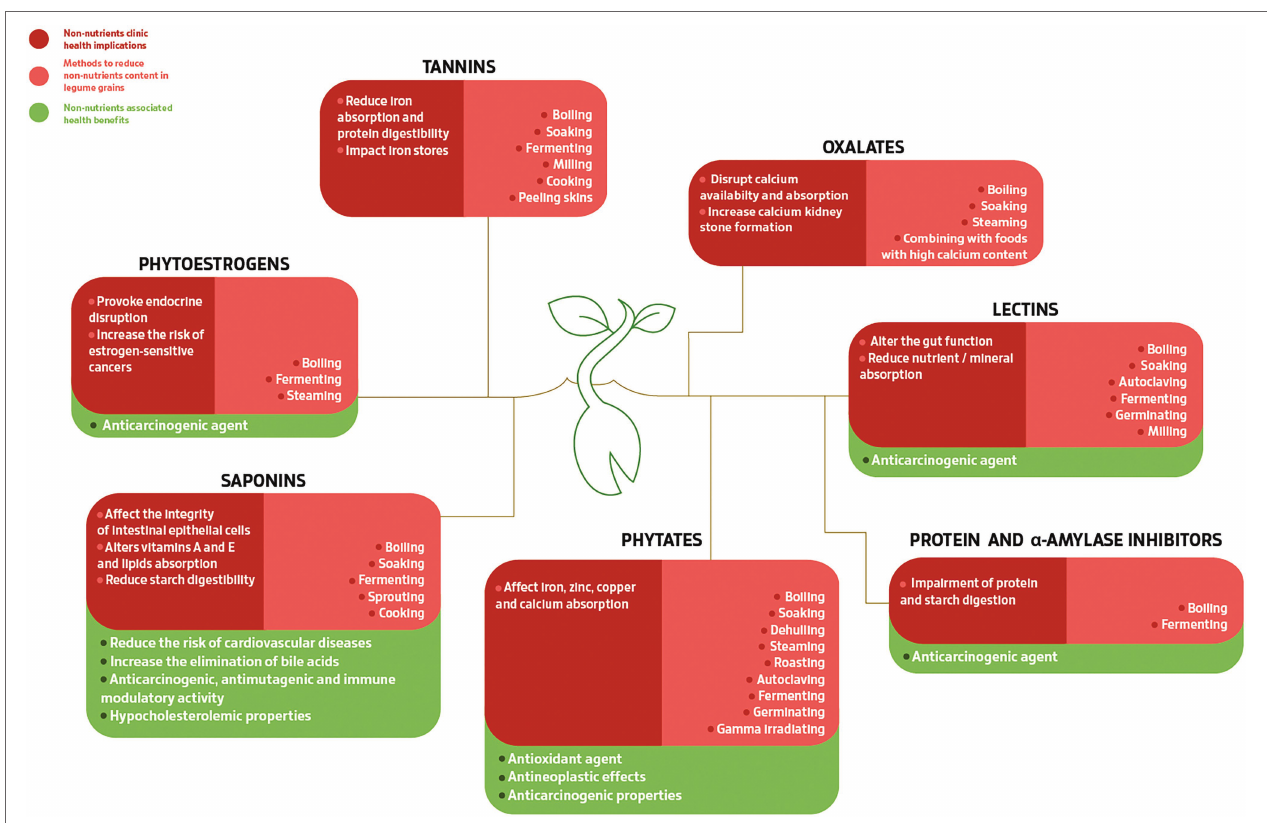
FIGURE 1 | Different non-nutrients found in legume grains, their clinical health implications, and methods to reduce their